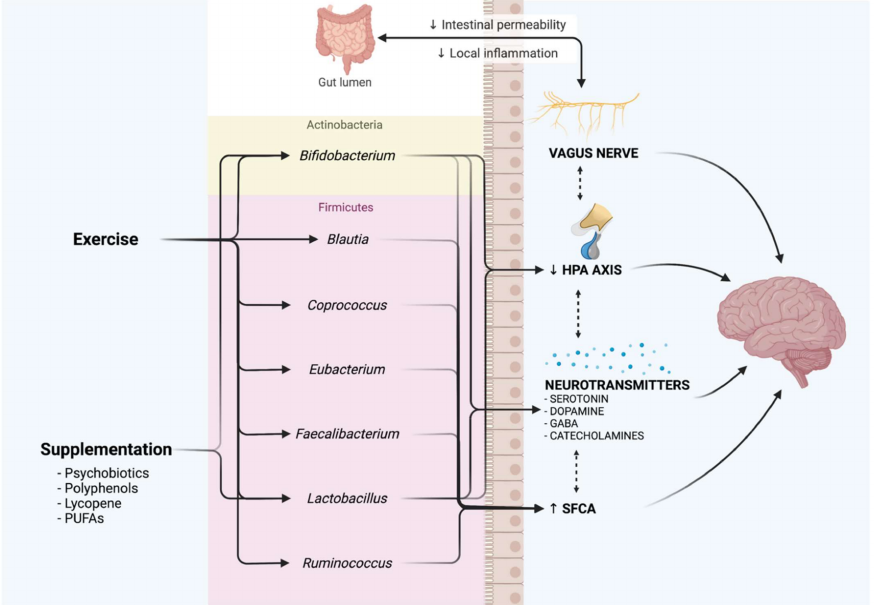
Figure 1. Effect of exercise and supplementation on the main microbiota genera associated with depressive disorders. Both exercise and supplementation cause an increase in the abundance of all the genera presented, which play a role in the communication between the gut and nervous system through the microbiota–gut–brain axis. Main pathways of action are also presented. Created with